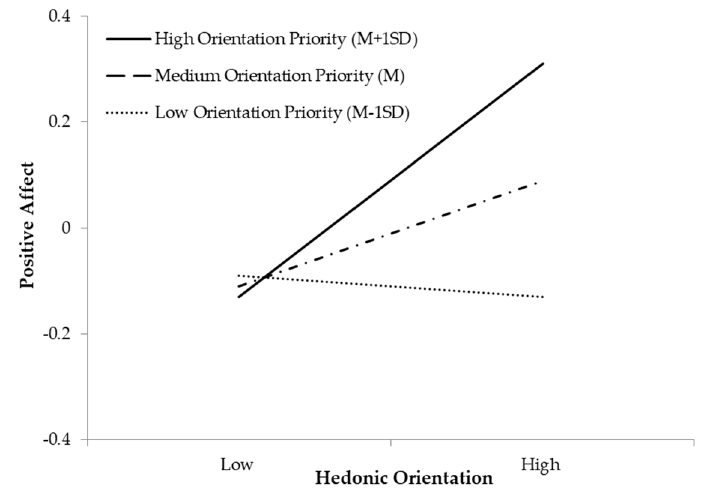
Figure 2. Orientation priorities moderate the effect of a hedonic orientation on positive affect. Table 4. Regression results using negative affect as a dependent